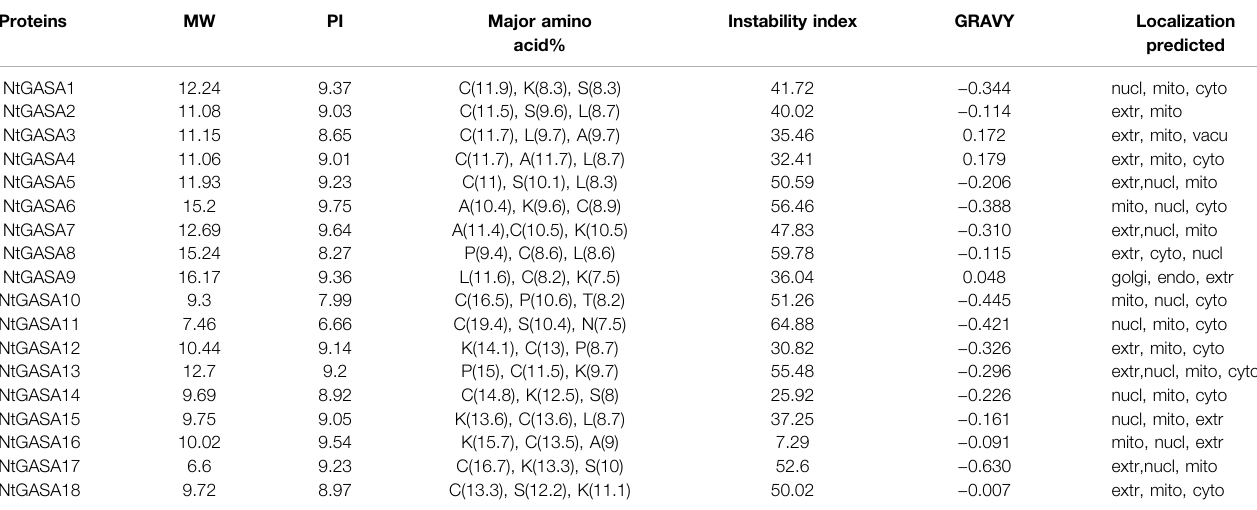
TABLE 2 | Amino acid composition and physiochemical characteristics of NtGASA protein. Proteins MW PI Major amino